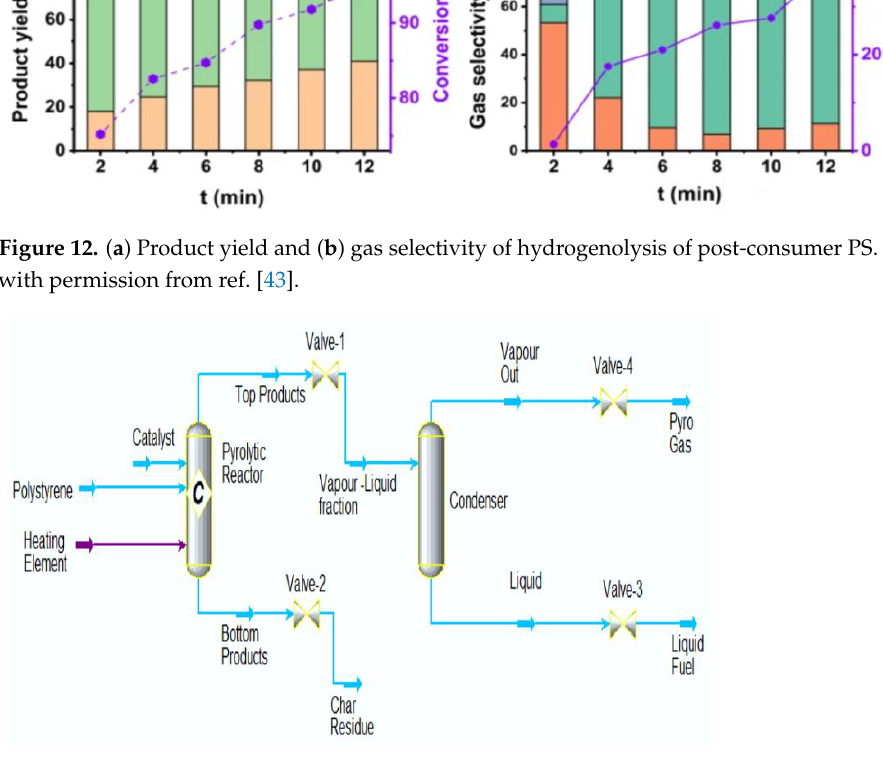
Figure 12. ( a ) Product yield and ( b ) gas selectivity of hydrogenolysis of post-consumer PS. Reprinted with permission from ref. [43].